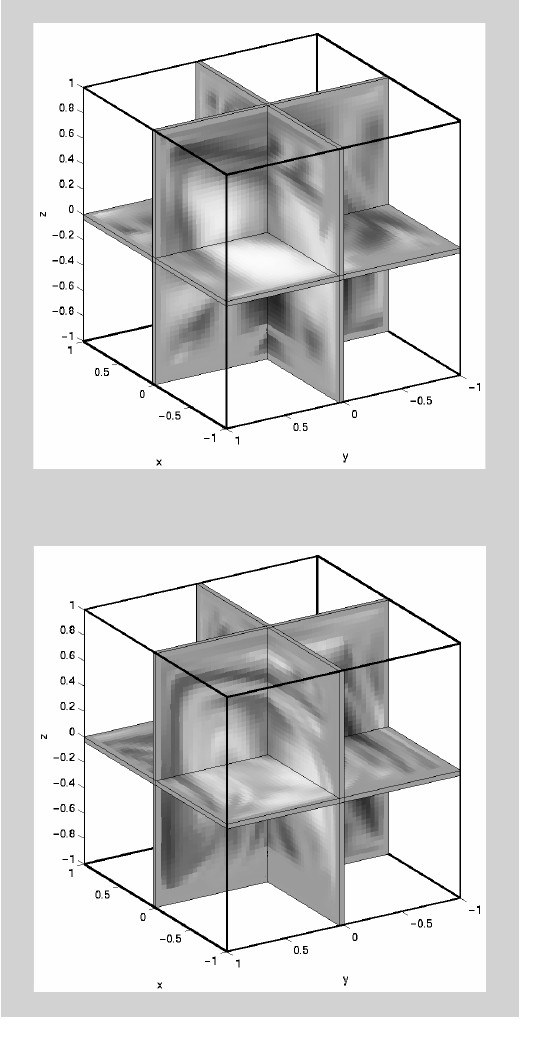
Figure 8: The concentration distribu- tion for D = 3 after a total of 100 dimensionless wall displacements is plotted on two cross-sections of the cubic cavity. Below it the result for D = 5 is